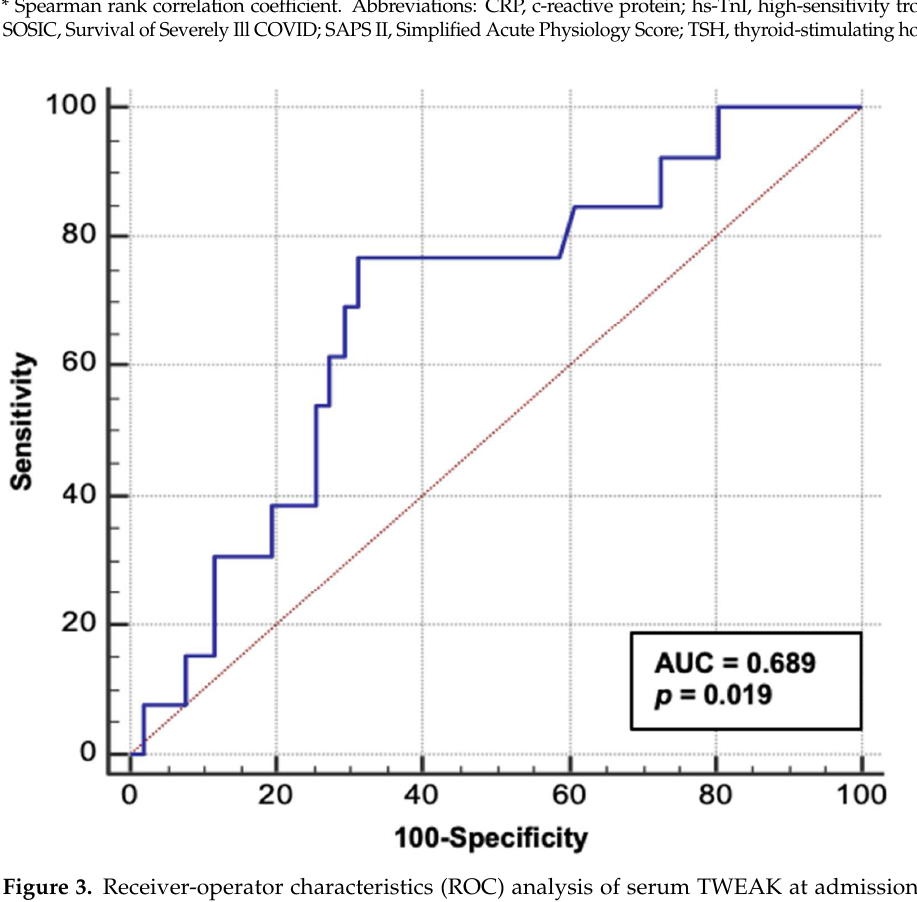
Figure 3. Receiver-operator characteristics (ROC) analysis of serum TWEAK at admission for in- hospital mortality. Abbreviations: AUC, area under the curve.